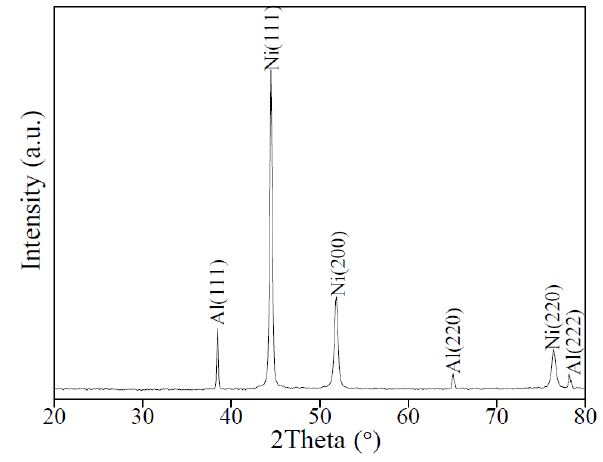
Figure 2. EDS element contents analysis for di ff erent parts ( a ) Point A and ( b ) Point B in Figure 1b.